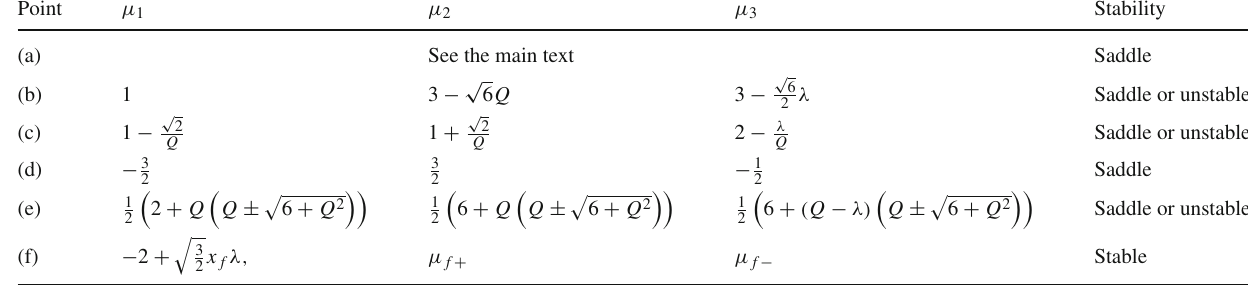
Table 2 Eigenvalues and stability of the fixed points for the quintessence field with interaction Q ρ φ Point Stability